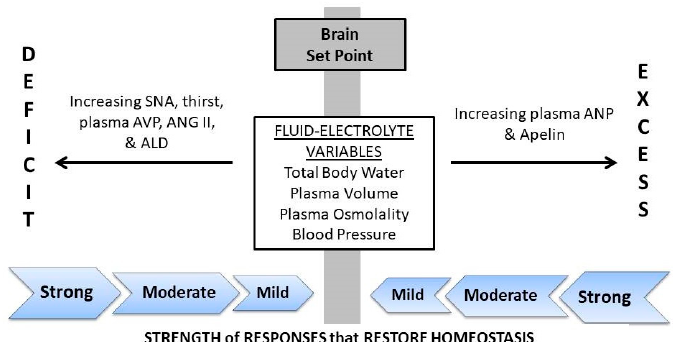
Figure 1. The hydration continuum. Perturbations of fluid-electrolyte variables initiate thirst and neuroendocrine responses to restore homeostasis and to maintain optimal health and function. The magnitude of a fluid-electrolyte deficit (DEFICIT) or fluid-electrolyte excess (EXCESS) determines the strength of responses that return volume, osmolality and pressure back to the encoded brain set point. Abbreviations: SNA, sympathetic nerve activity; AVP, arginine vasopressin; ANG II, angiotensin II; ALD, aldosterone; ANP, atrial natriuretic peptide. Revised from Armstrong & Johnson, 2018 [41].